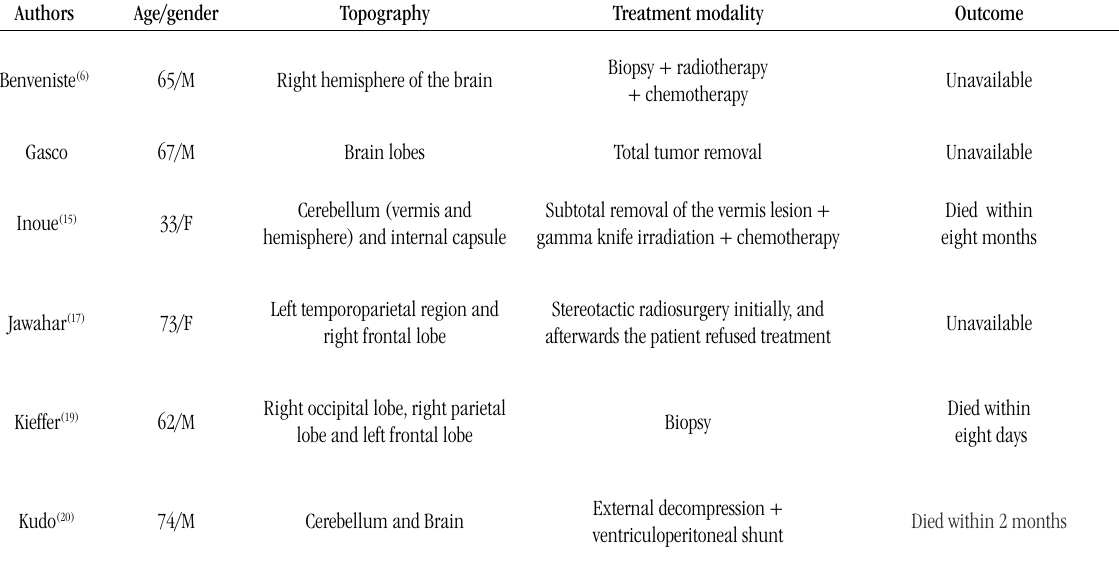
tABLE – Summary of some published cases of multicentric glioblastoma confirmed by histopathological examination